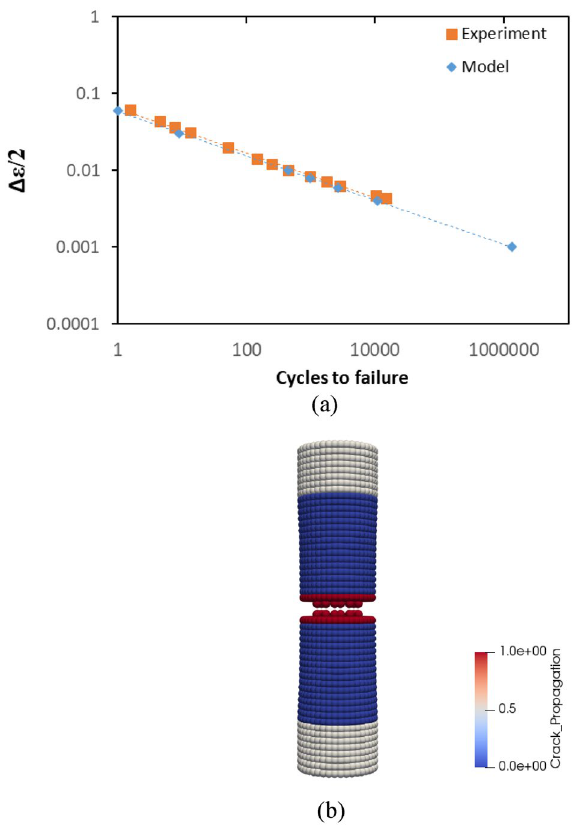
Figure 10. Aluminium alloy. ( a ) A comparison between the experiment and PD simulation in the case of crack initiation. ( b ) A picture of failure mode for crack initiation from PD